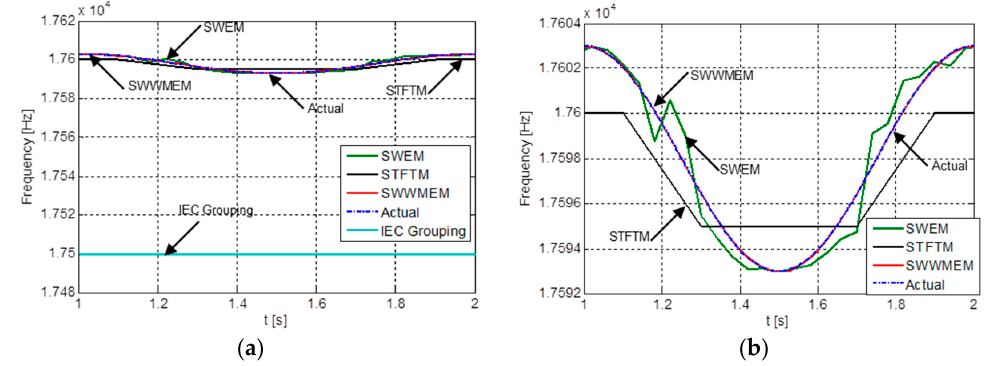
Figure 6. Case study 2: comparison among the actual time-varying frequency and its estimations obtained through: ( a ) IEC grouping, STFTM, SWEM and SWWMEM; ( b ) STFTM, SWEM and SWWMEM.